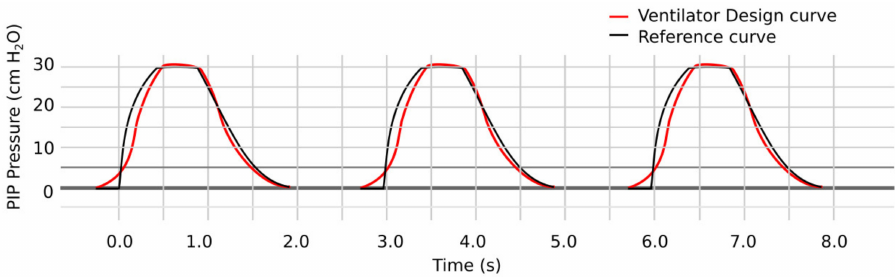
Figure 9. Designed ventilator pressure curve vs. reference curve.